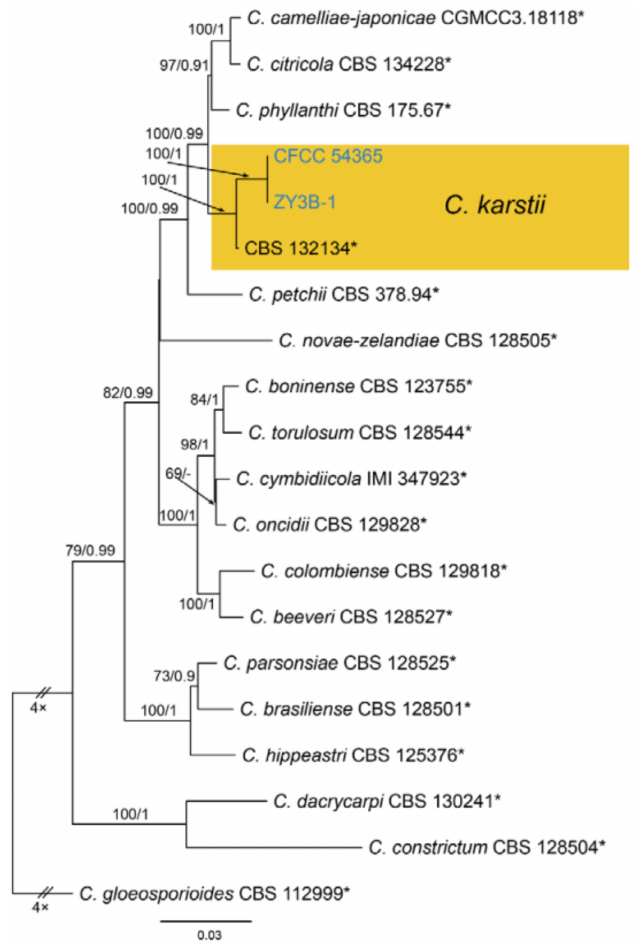
Figure A14. Phylogram generated from RAxML analysis based on combined ITS, act , chs-1 , gapdh and tub2 sequence data of Collectrichum boninense species complex isolates. The tree was rooted to Collectrichum gloeosporiodes (CBS 112999). The scale bar indicates 0.03 nucleotide changes per site. Isolates from this study are marked in blue, ex-type strains are marked with *, and the identified species is marked in